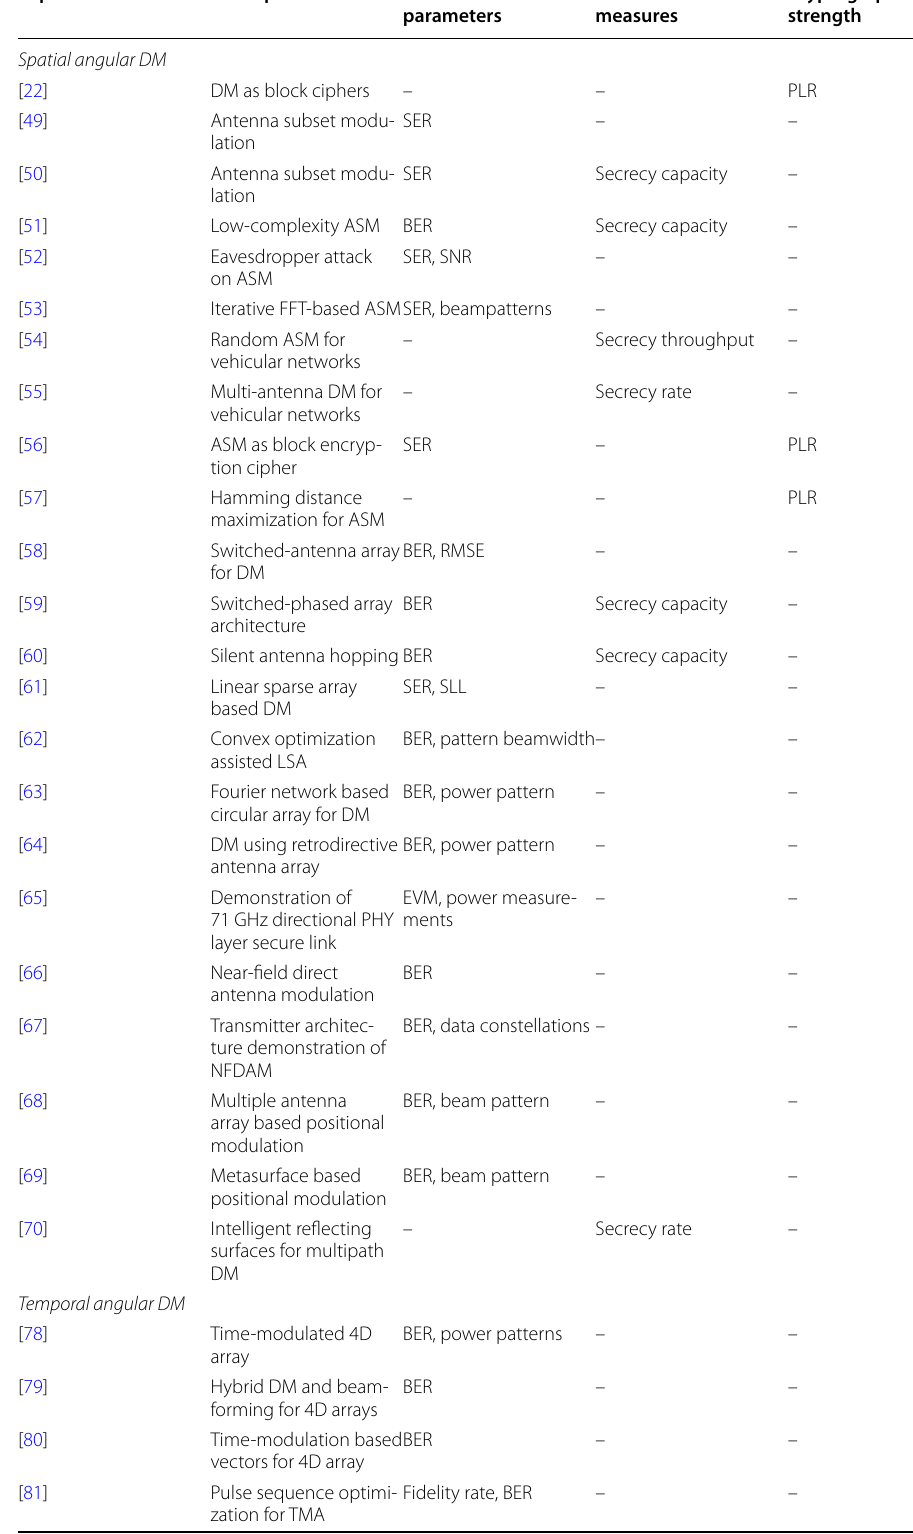
Table 3 Secure communication using angular directional modulation